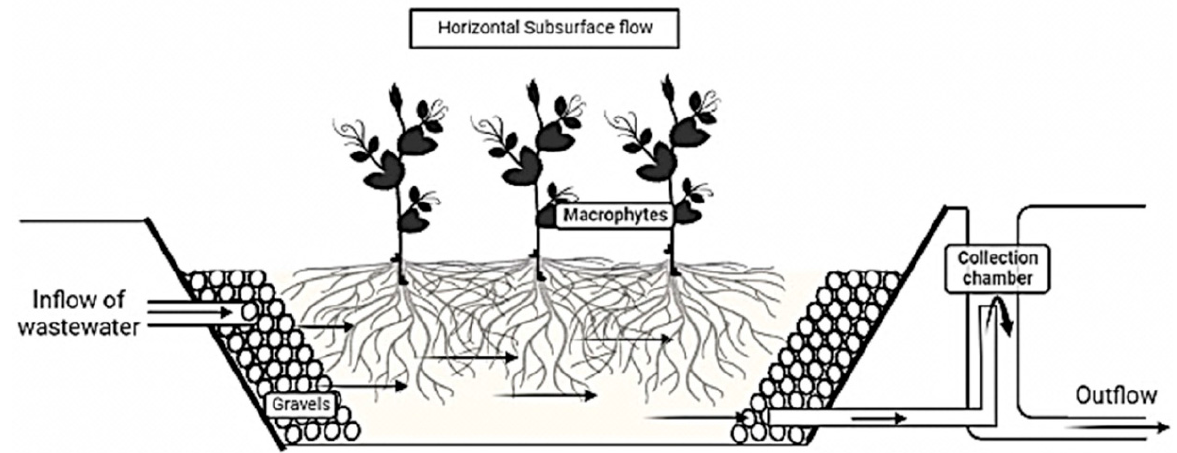
Figure 4. Horizontal subsurface flow-constructed wetland.